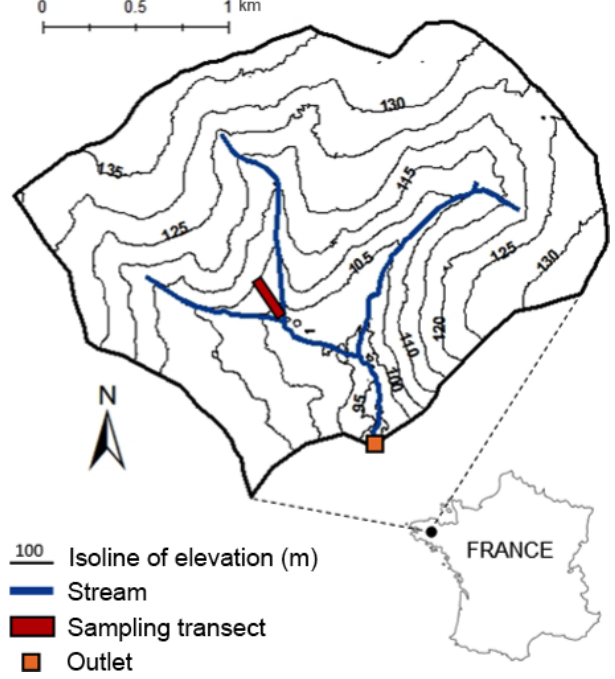
Figure 1. Map of the Kervidy–Naizin catchment (Brittany, France). The soil solutions were sampled in the wetland area of the transect. The stream waters were sampled at the outlet of the